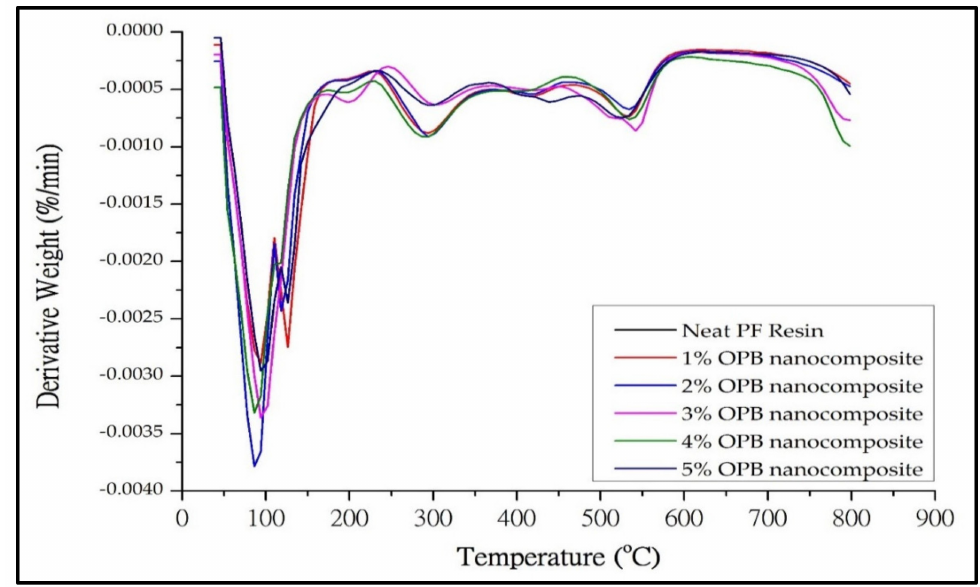
Figure 6. DTG thermogram of neat PF and PF nanocomposite-filled OPB nanoparticles with different